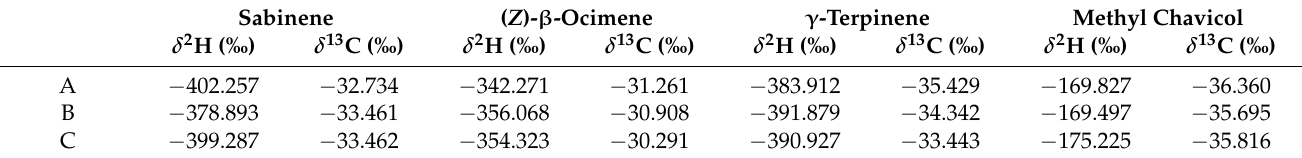
Table 3. Stable isotope ratios, δ 2 H and δ 13 C, for sabinene, cis - β -ocimene, γ -terpinene, and methyl chavicol. Samples were analyzed in triplicate to ensure repeatability ( δ 2 H values are reported with a standard deviation ≤ 2.6‰ and δ 13 C values are reported with a standard deviation ≤ 0.2‰). δ 2 H isotope ratios are expressed relative to VSMOW and δ 13 C isotope ratios to